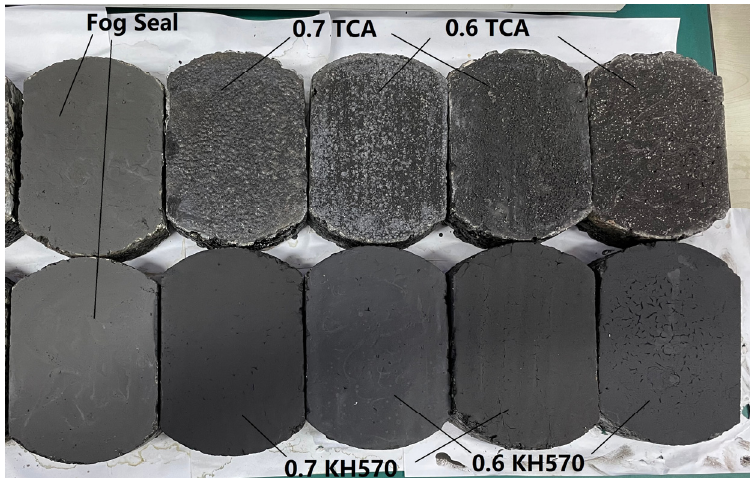
Figure 7. British pendulum number (BPN) samples prepared under different material ratios and coupling agent.